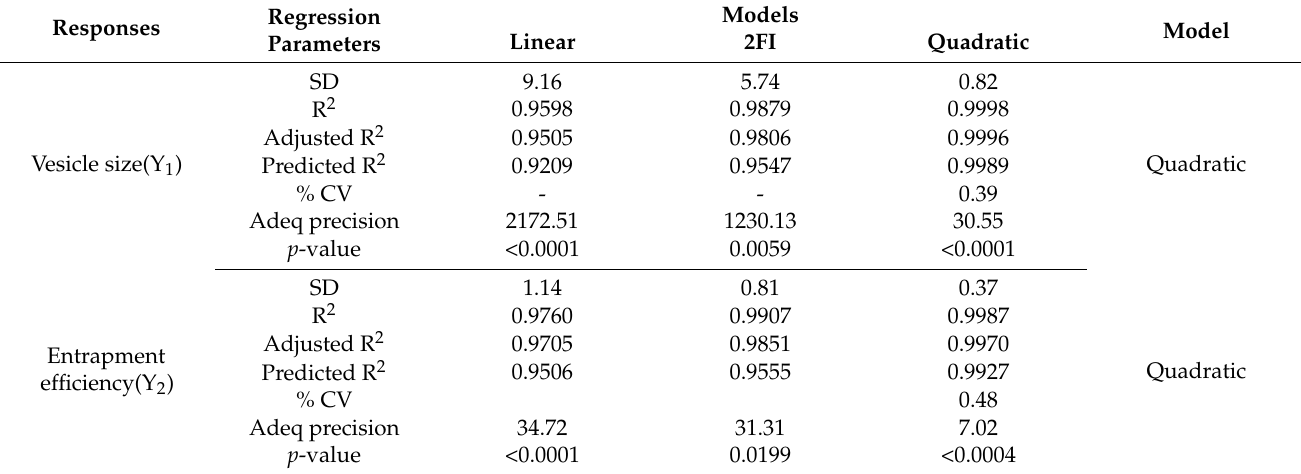
Table 3. Statistical model summary of selected dependent